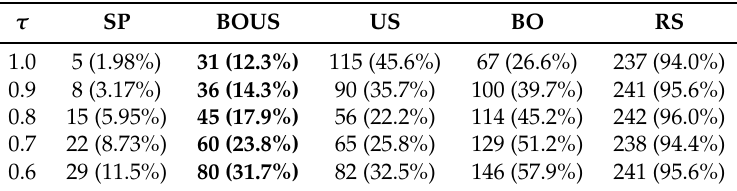
Figure 4. Performance of successful parameter search for Newtonian dynamics simulations using BOUS, US, BO, and RS. The success thresholds were 1.0 ( a ), 0.9 ( b ), 0.8 ( c ), 0.7 ( d ), and 0.6 ( e ), respectively. The dashed blue line shows the total number of successful parameters for each threshold. ( f ) shows the efficiency of the search for best parameter detection using BO and RS with τ = 1.0. Table 1. Numbers of samplings required to detect all successful parameters with a probability of 95% or higher using BOUS, US, BO, and RS. SP indicates the number of successful parameters. The values in parentheses indicate the ratios of the number of calculations in the exhaustive search. The total number of parameter candidates was